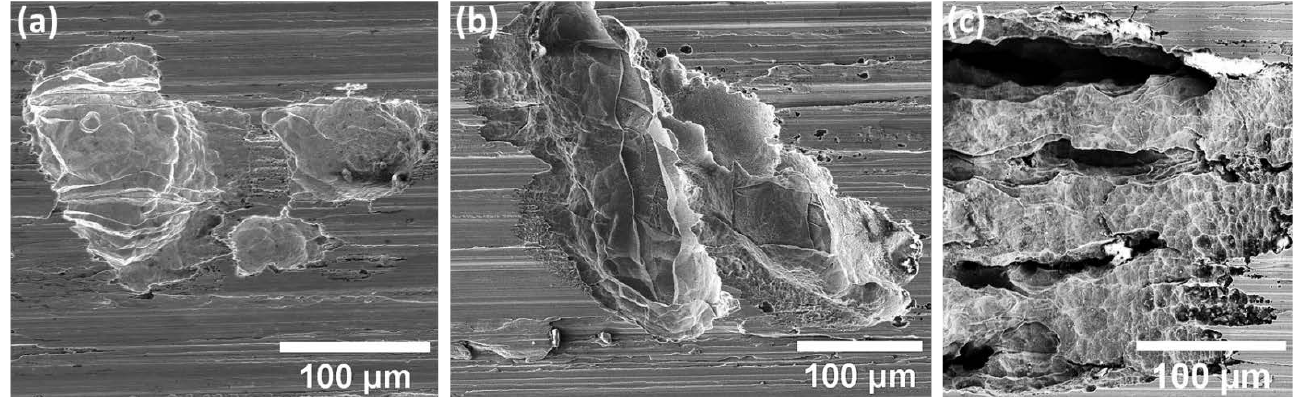
Figure 7. SEM microstructural analysis of the corroded surface of ground specimens of ( a ) group one, ( b ) group two, and ( c ) group three highlighting the morphology of SCC initiation and corrosion characteristics.